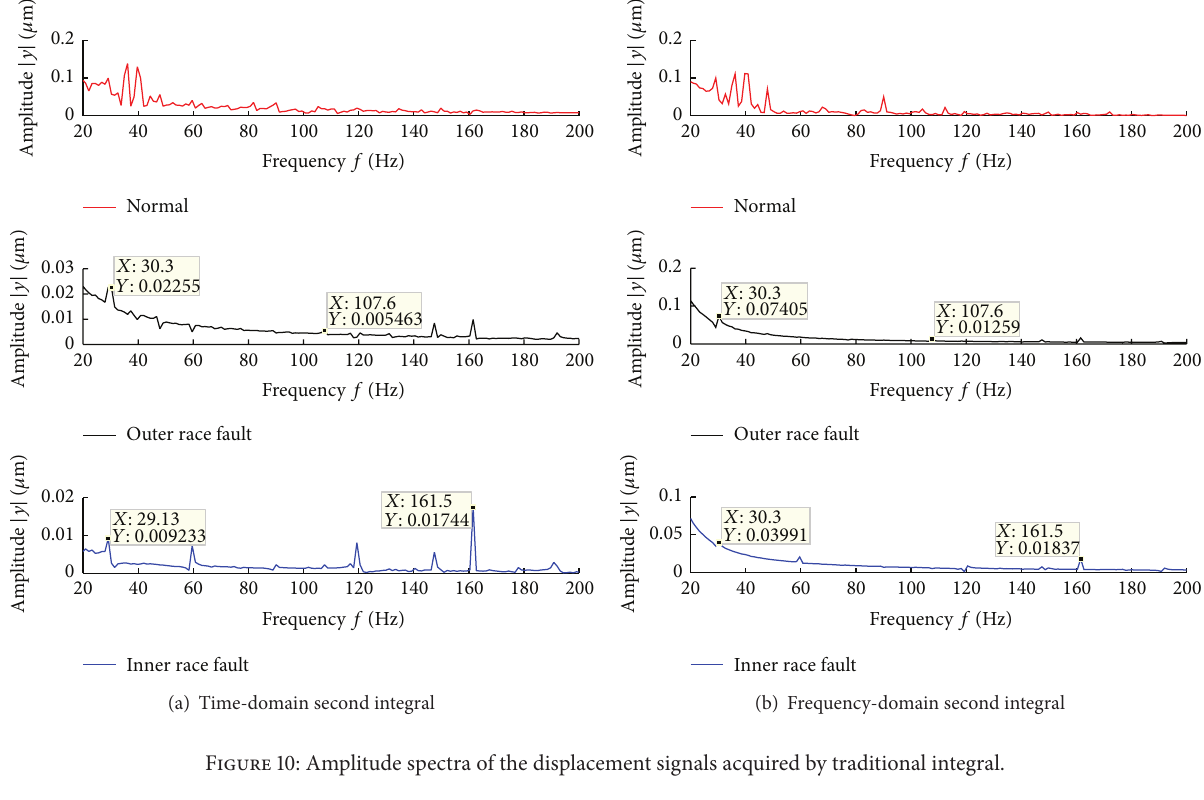
Figure 10: Amplitude spectra of the displacement signals acquired by traditional integral.